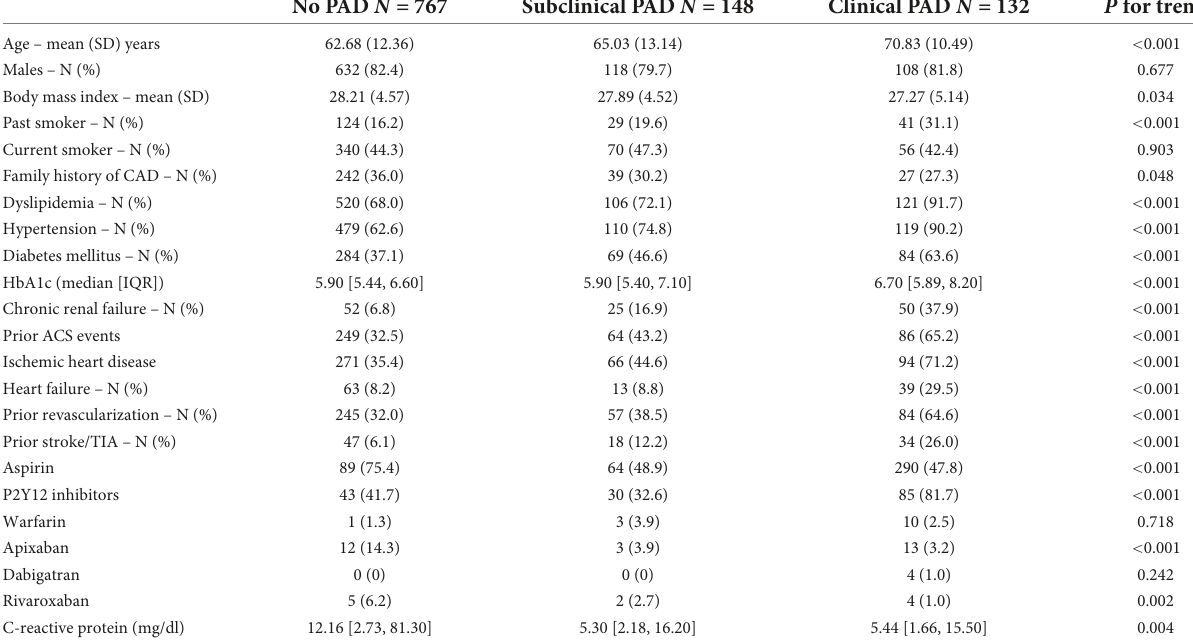
TABLE 1 Population baseline